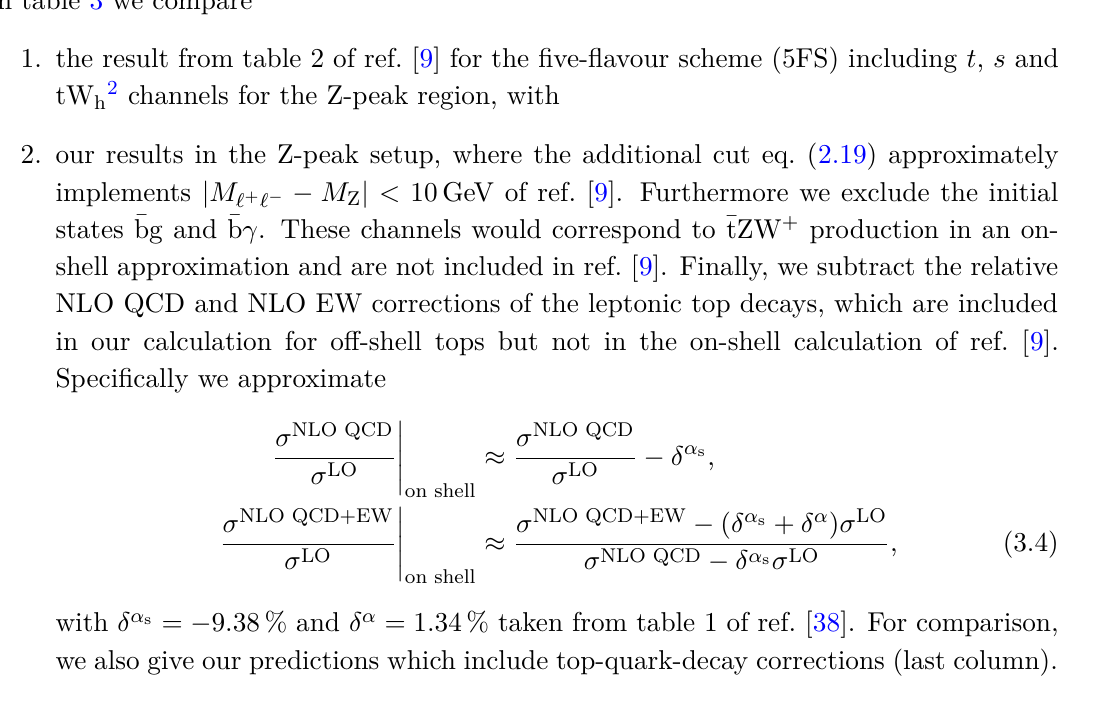
is the one with the ¯ q initial state, which only receives s -channel contributions, while q u d all other partonic channels receive only t -channels contributions at LO. The relative EW corrections to the individual channels range between − 6% and − 13%